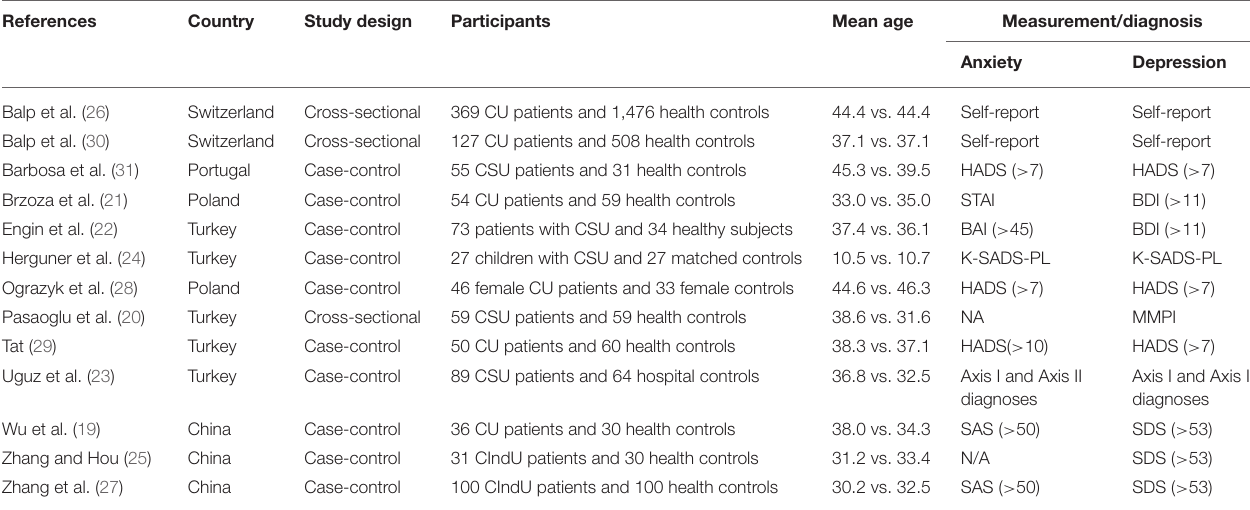
TABLE 1 | Characteristics of the included